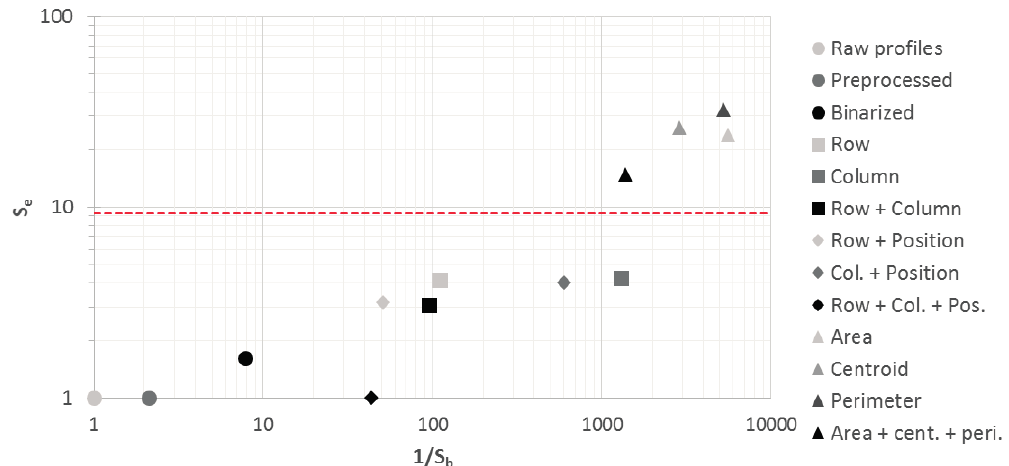
Figure 15. Error increment vs. burden